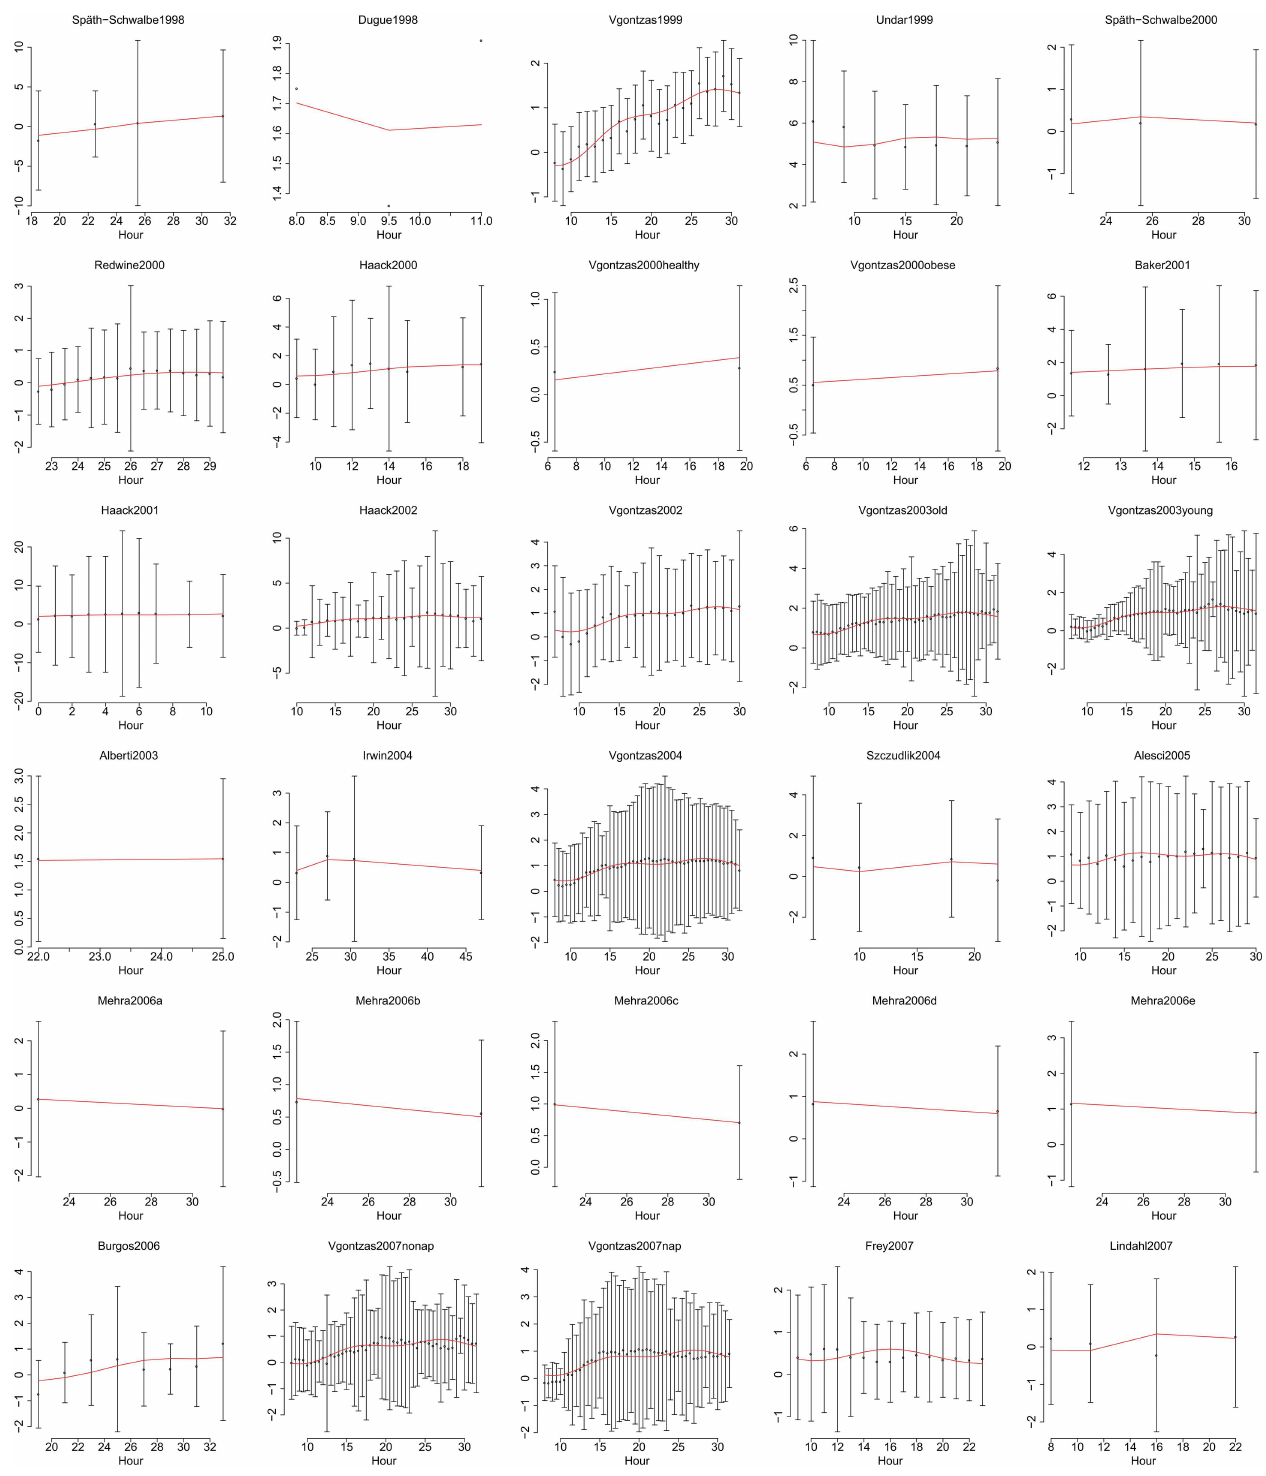
Fig 5. Data and fitted time courses, showing the first 30 out of 56 datasets. Data are shown as estimated from originalpublications, with error bars showingstandard deviations. Y axes show ln IL-6 (pg/ml) throughout. Hours are in chronological time where 1 is 01:00 on the first day. Red lines show predictionsfrom the best-fitting